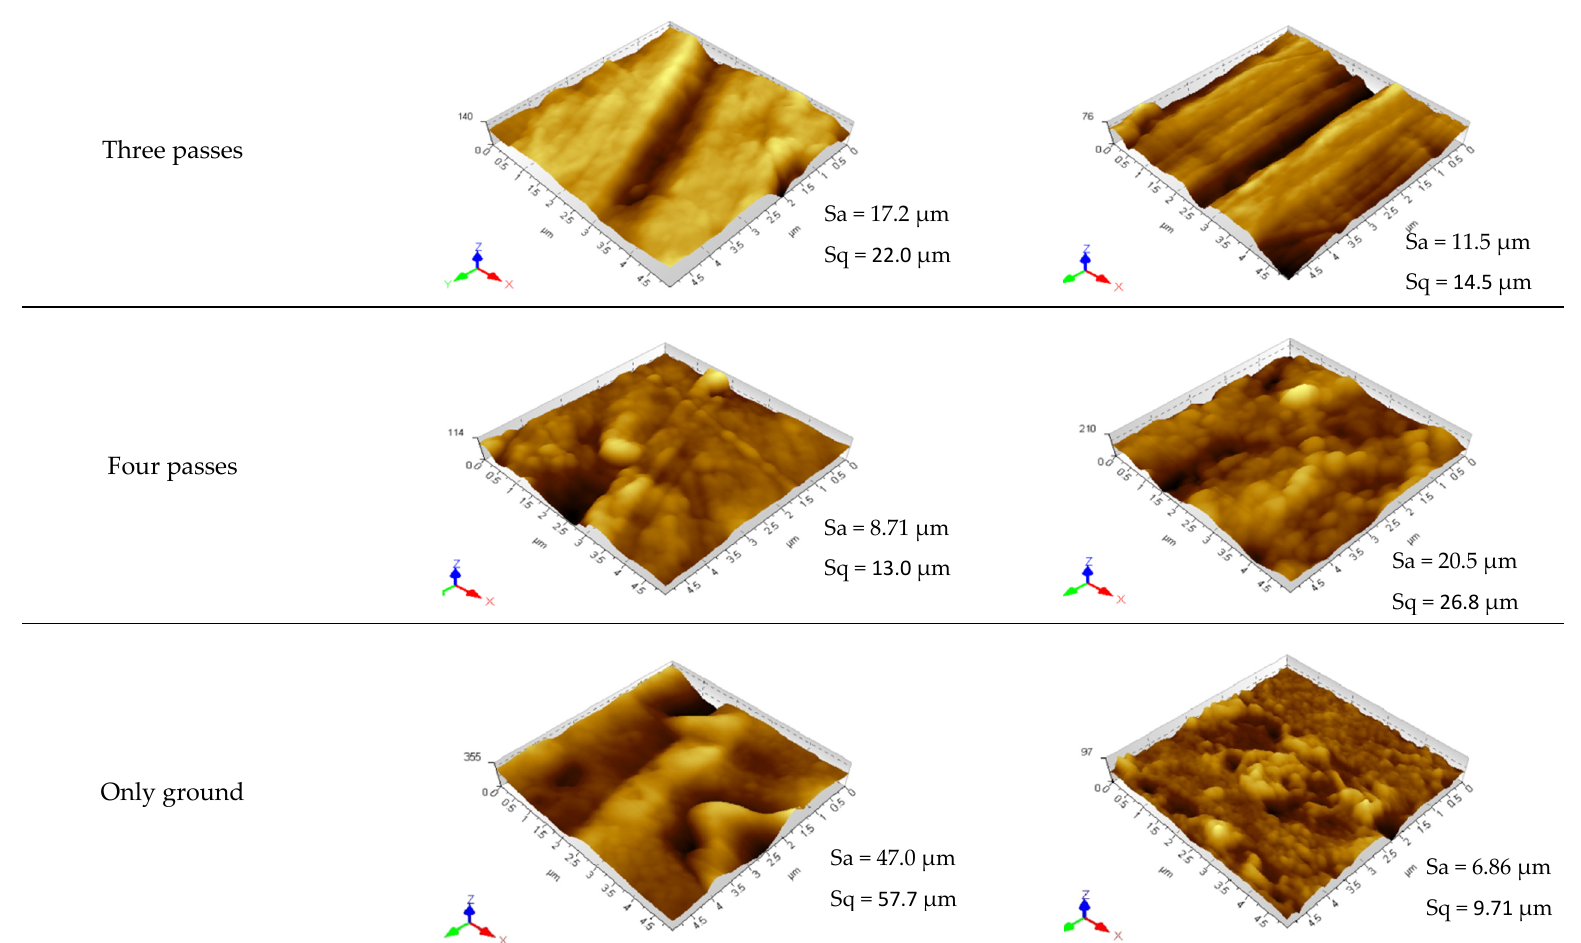
Figure 7. AFM topography images and roughness (Sa and Sq) for all sample.